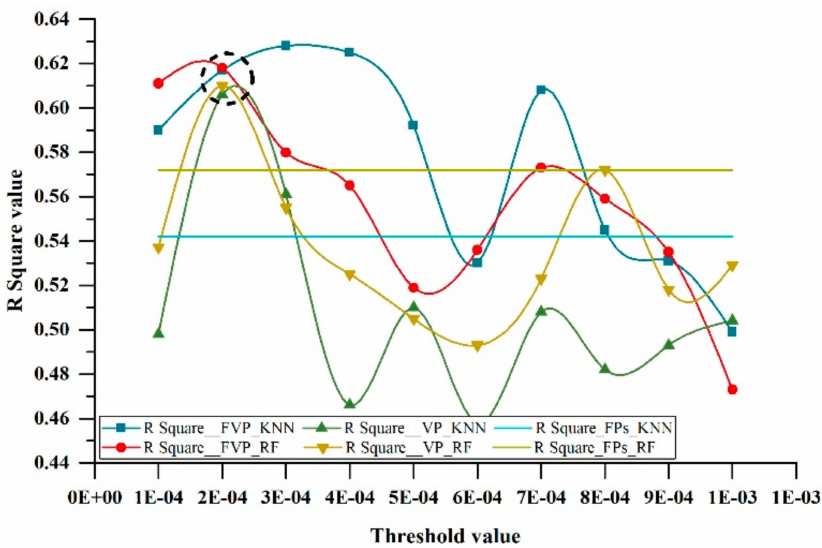
Figure 7. Variations of R squared values with di ff erent sample combinations and